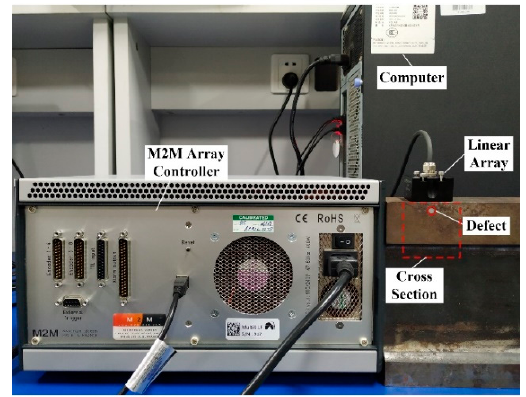
Figure 3. Schematic diagram of the data acquisition system. Table 1. Array controller settings.